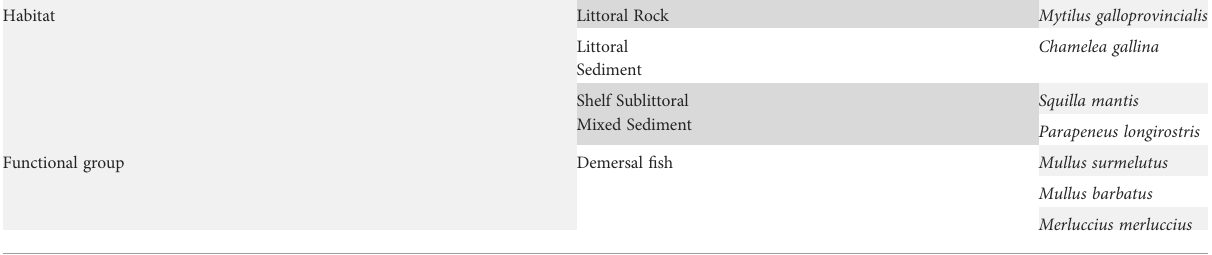
TABLE 4 Main species measured for each habitats and functional groups. Habitat